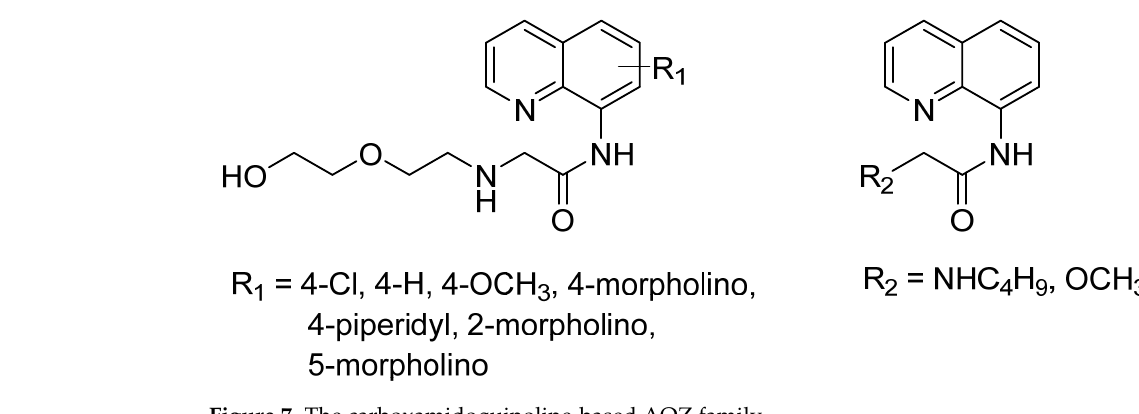
Figure 8. The structures of QP, QA, and NA.